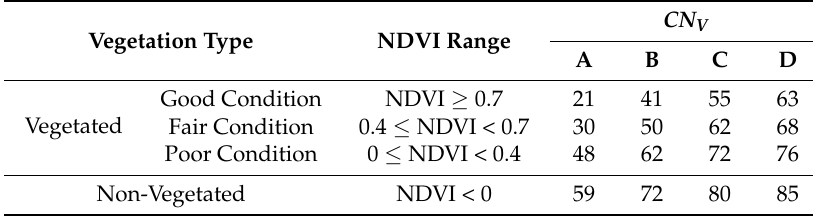
Table 1. Vegetation classification and values of vegetation curve number ( CN V ) in dry antecedent moisture condition (AMC-I).